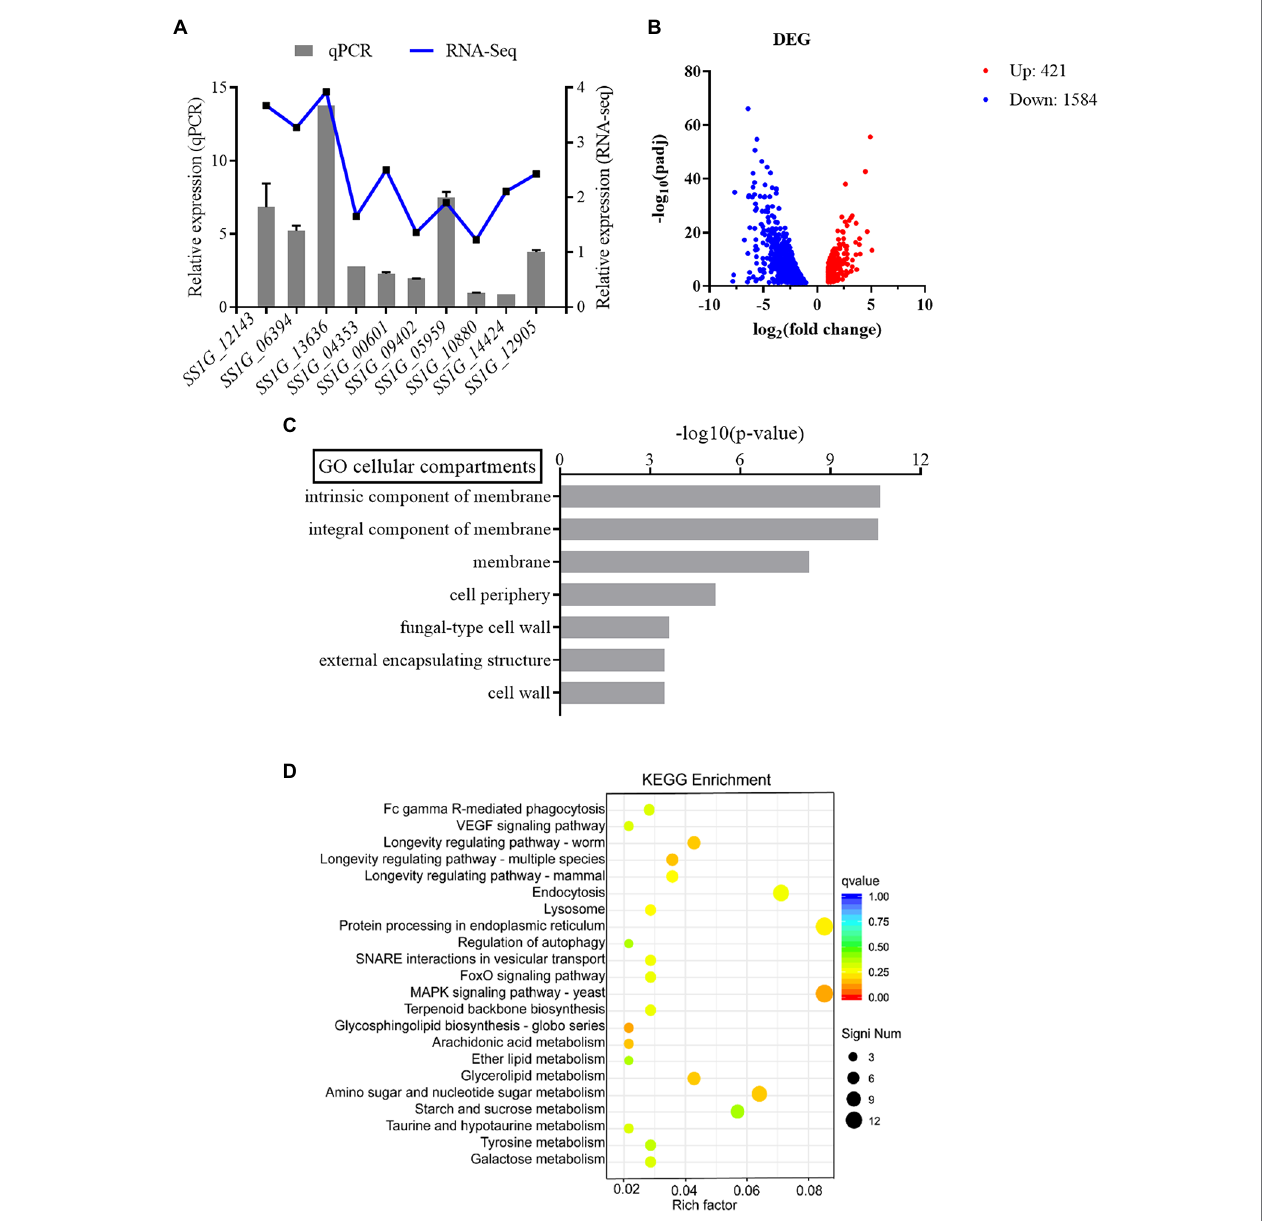
FIGURE 3 | (A) The relative mRNA expression levels of DEGs and values of |Log2FC| (treatment group/control group) in RNA-seq. (B) Differential gene expression of WT and Δ Ssfkh1 . Each point in the figure represents a gene, in which red indicates an upregulation gene, blue indicates a downregulation gene. (C) Gene ontology analysis (upregulation gene). Classification of the annotated amino acid sequences. Amino acid sequences were grouped into different functional subcategories: cellular component (CC), molecular function (MF), and biological process (BF). (D) KEGG pathway enrichment